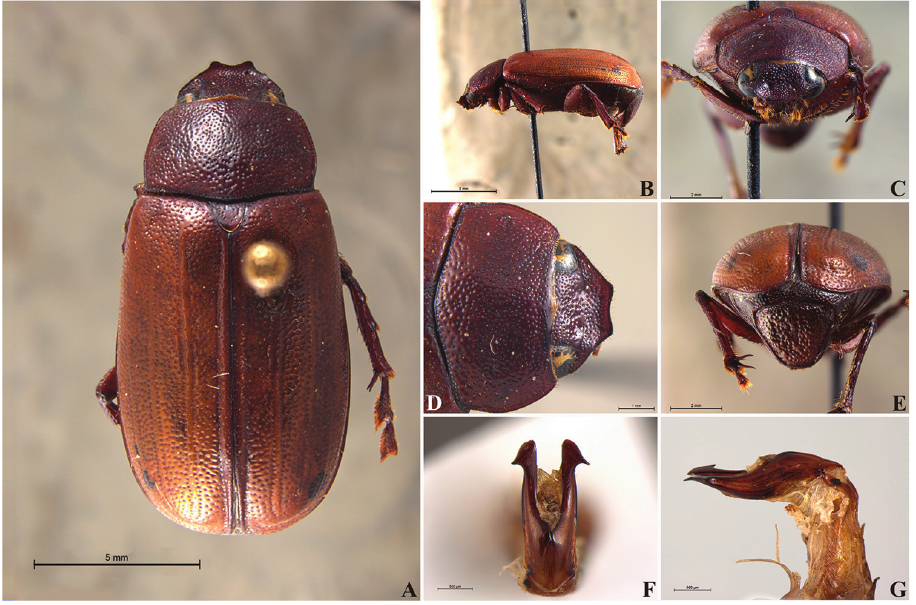
Figure 69. Liogenys punctaticollis Blanchard. A Dorsal view B Lateral view C Frontal view D Clypeus and pronotum E Pygidium F Parameres, dorsal view G Parameres, lateral view. total length of parameres near five times the length of their apex; inner margins con- vergent; apex harpoon-like with lateral angle curved projecting almost perpendicular to parameres (Fig.